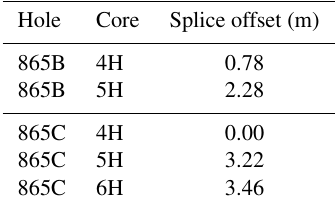
Table 1. Composite depth offsets within splice for ODP Site